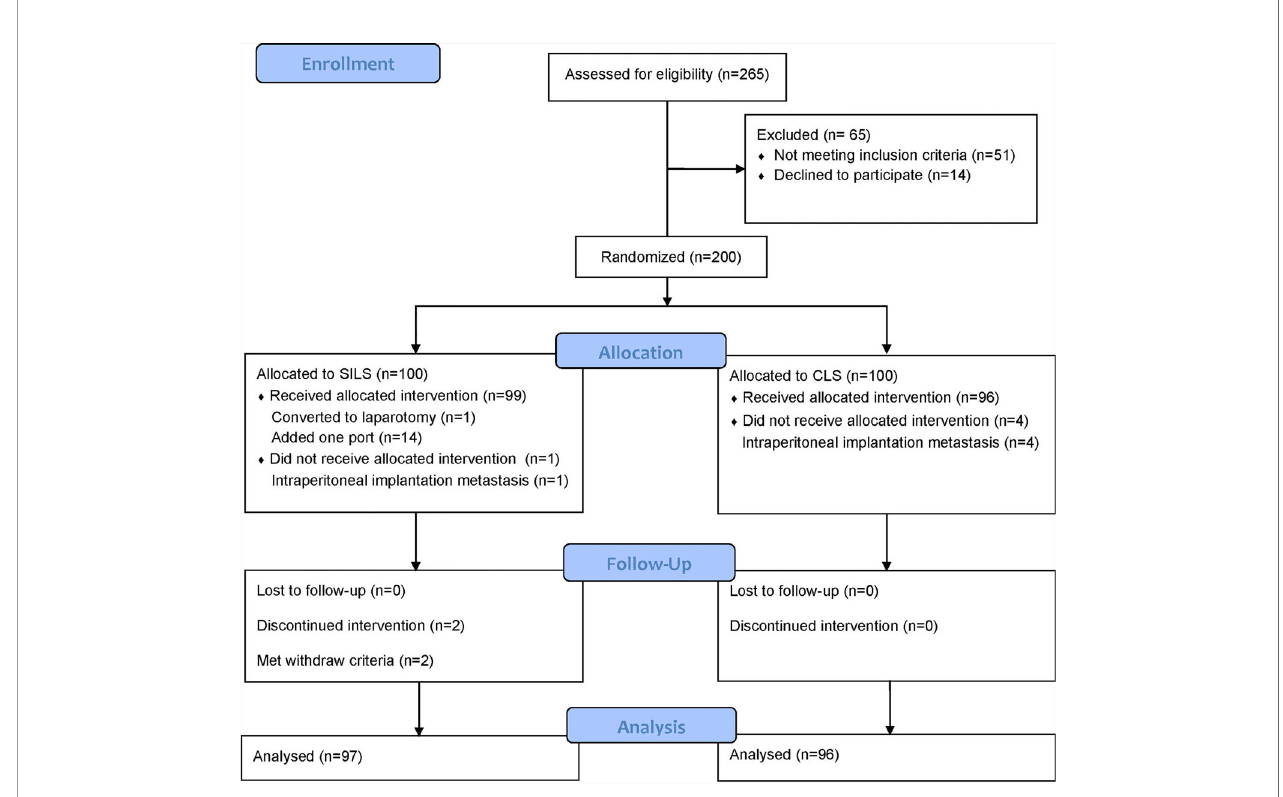
FIGURE 1 | Consort fl ow